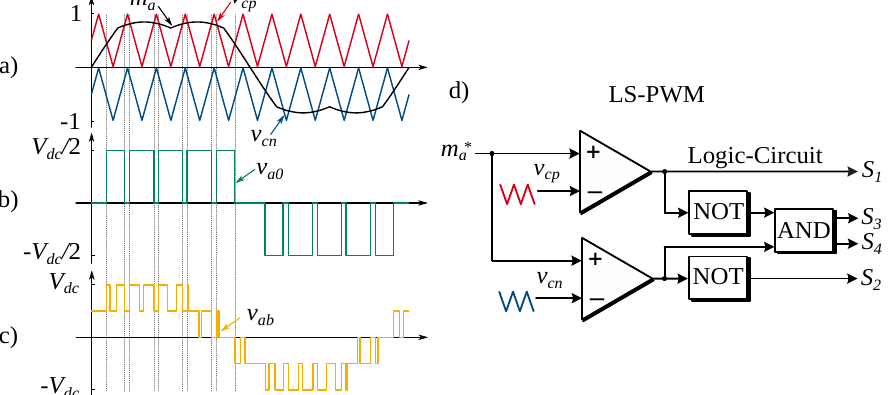
Figure 4. LS-PWM applied to a 3L-TNPC leg: ( a ) Triangular carriers and modulation signal, ( b ) generated phase voltage, ( c ) generated line-to-line voltage, and ( d ) analog